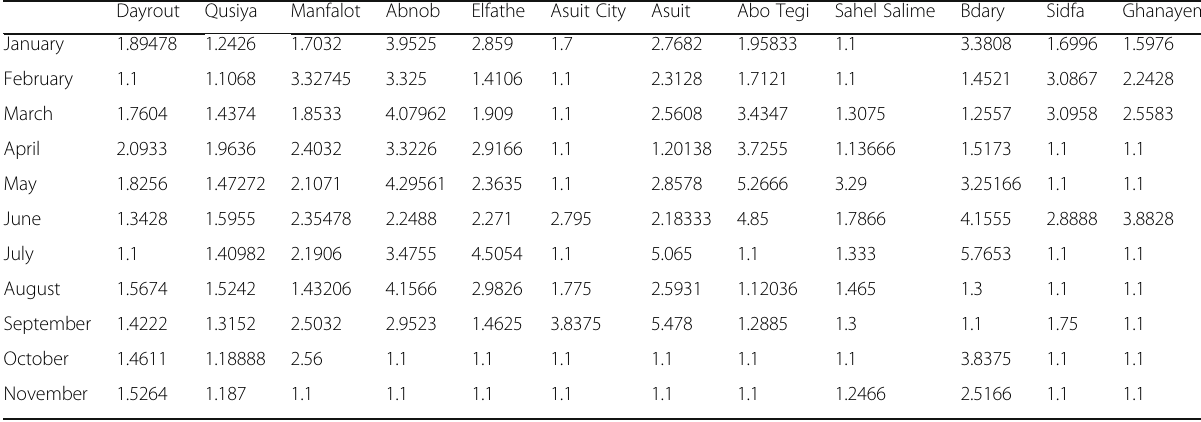
Table 5 Total coliform averages (MPN/100 ml) (2017)